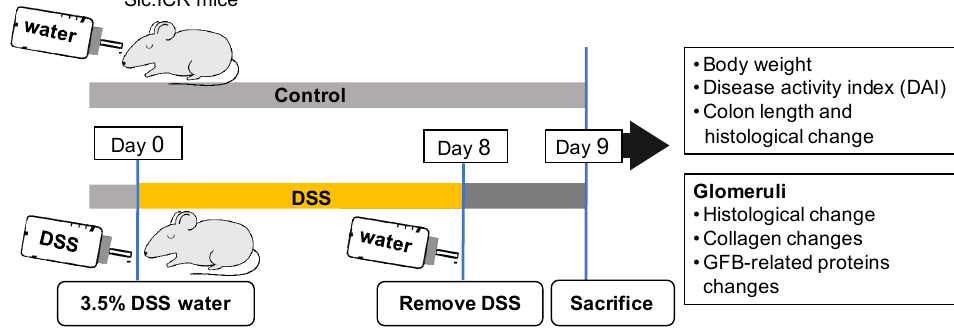
Figure 1. Investigating mouse glomerular structural changes associated with dextran sulfate sodium (DSS)-induced colitis. Slc:ICR mice were administered 3.5% DSS in drinking water for eight days, then allowed intake of filtered water on Day 8. Control mice were given filtered water. All mice were sacrificed on Day 9 and further assessments were performed. Abbreviation: GFB, glomerular filtration barrier.